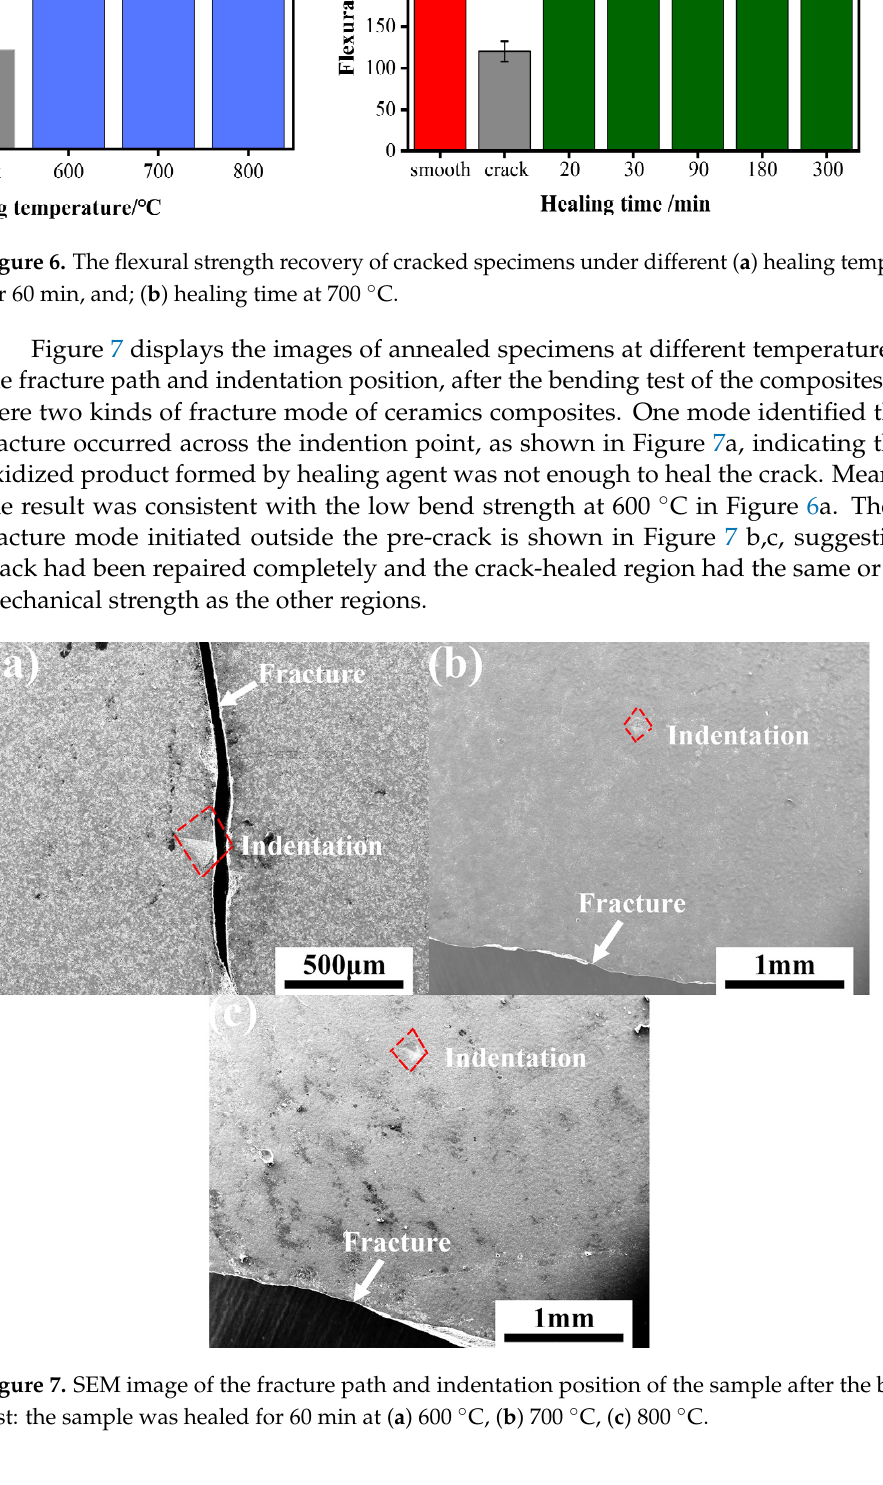
Figure 7. SEM image of the fracture path and indentation position of the sample after the bending test: the sample was healed for 60 min at ( a ) 600 °C, ( b ) 700 °C, ( c ) 800 °C.